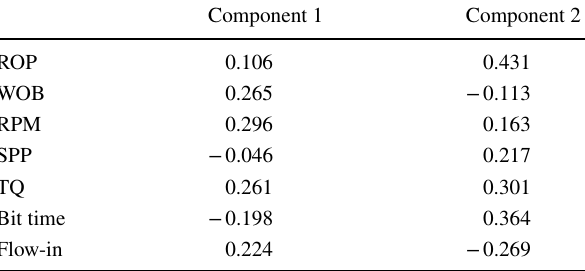
Fig. 2 Wavelet transform of decomposition and reconstruction Table 1 Component score coefficient matrix Component